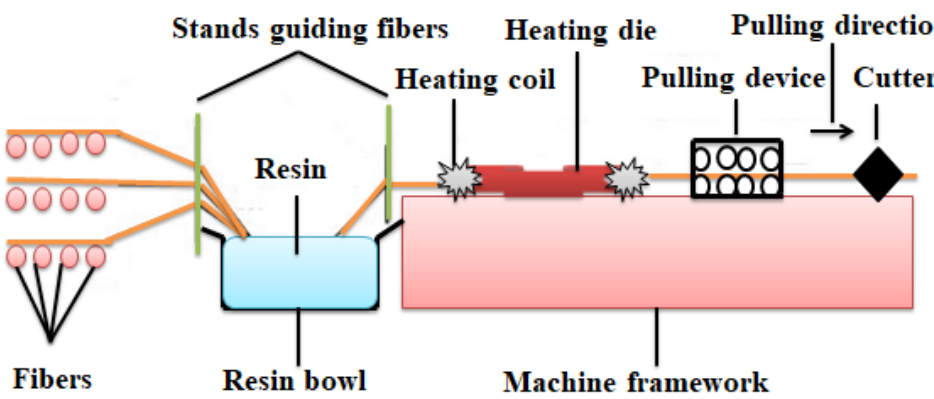
Figure 4. Image of Pultrusion Process Adapted and Redrawn from [61].